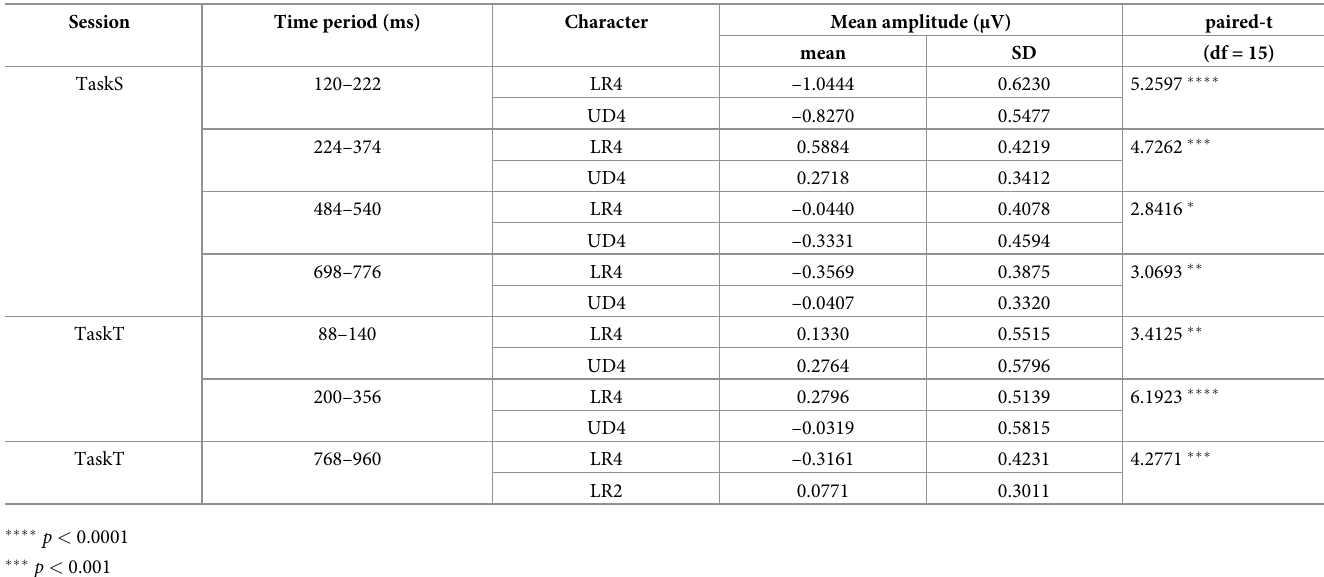
Table 4. Effects of IC1 reflecting extraction of abstract structural or tonal pattern.